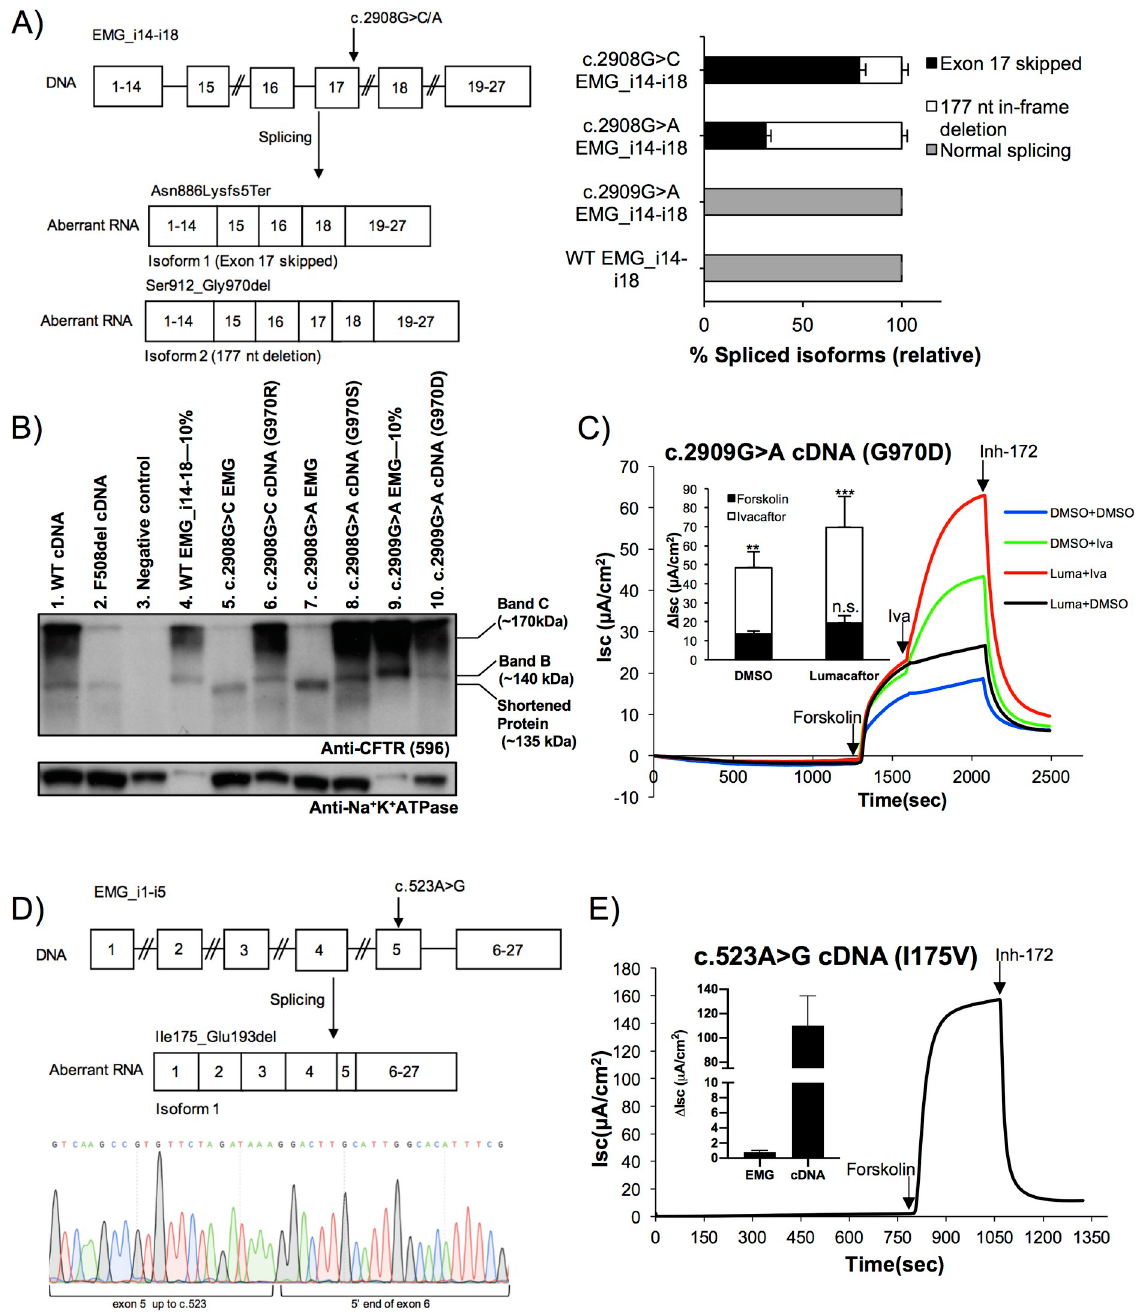
Fig 2. Variants at codon 970 have different effects on mRNA splicing, protein processing and function of CFTR. (A) c.2908G > C (predicted effect G970R) and c.2908G > A (predicted effect G970S) alter mRNA splicing, while c.2909G > A (predicted effect G970D) allows synthesis of normally spliced CFTR mRNA. Left panel. Schematic showing EMG_i14-i18 bearing c.2908G > A or c.2908G > C and CFTR mRNA isoforms produced. Right panel. Fragment analysis of RT-PCR products labelled with 6-FAM reveals the relative abundance of misspliced isoforms of CFTR transcript for EMG_i14-i18 bearing c.2908G > C or c.2908G > A. EMG_i14-i18 bearing c.2909G > A and wildtype (WT) EMG_i14-i18 served as controls. RNA isoform quantity was determined from the area under the curve (AUC) for each RT-PCR (minimum of three technical replicates per construct). The percent shown for each isoform is relative to the sum of the AUC for both isoforms. Error bars represent standard deviations. (B) EMGs with c.2908G > C and c.2908G > A do not produce processed CFTR protein, while c.2909G > A does . Immunoblot of protein lysates from transiently transfected HEK293 cells showing CFTR on top, with Na + ,K + - ATPase on bottom as a loading control. Band C is mature, complex glycosylated CFTR protein. Band B is immature, core glycosylated CFTR protein. Negative control is an empty vector plasmid. WT cDNA, F508del cDNA, and WT EMG_i14-i18 served as controls. WT